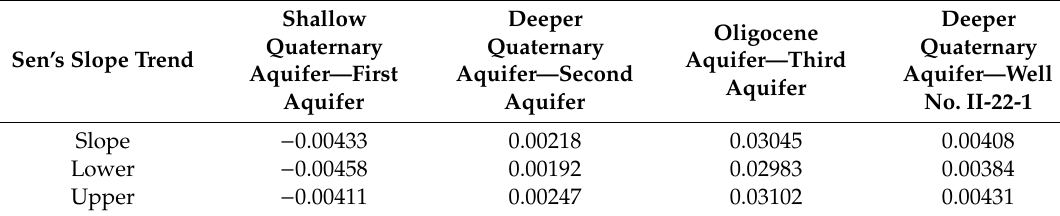
Table 3. Sen’s slope trend water table position.